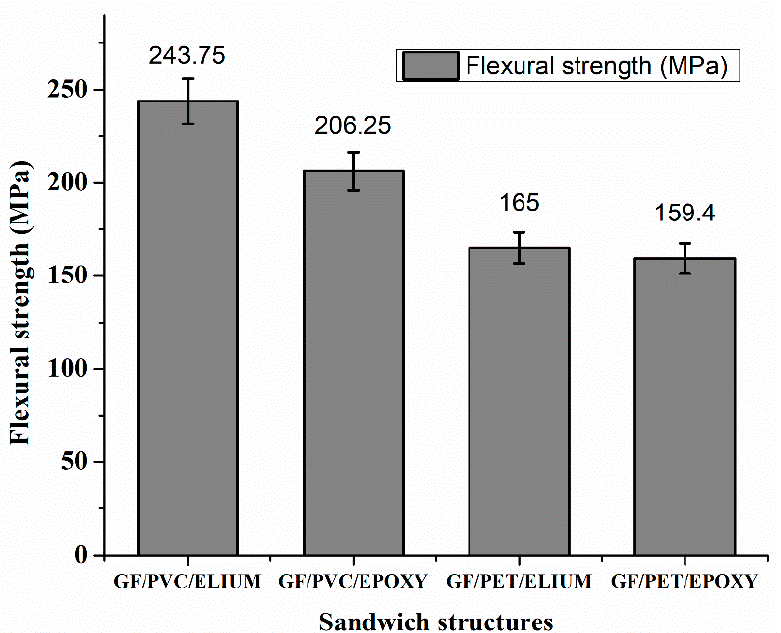
Figure 7. Load of GFRP sandwich composite structures.